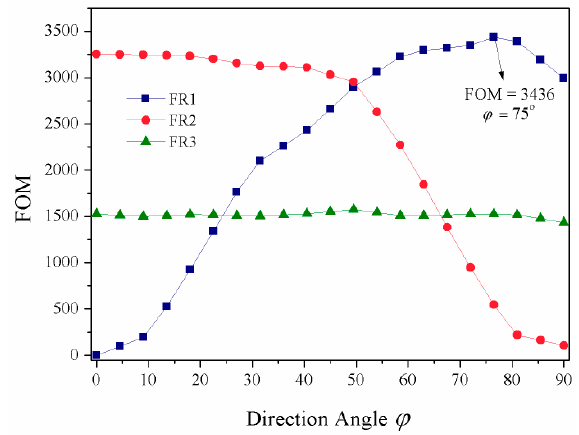
Figure 5. The figure of merit (FOM) values of the Fano resonances FR1, FR2, and FR3 related to the direction angle φ .